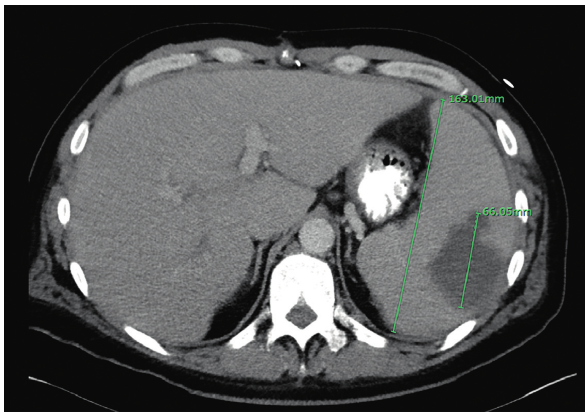
Figure 1: CTscan of the abdomen and pelvis with contrast showing splenic infarct with large splenic abscess collection in size of 66.05mm and the enlarged spleen in size of